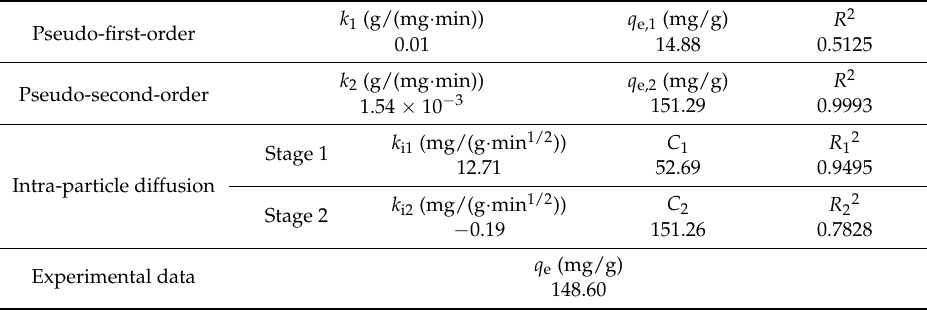
Table 2. Parameters of kinetic models on the adsorption of Pd(II) by AQ-PGMA.